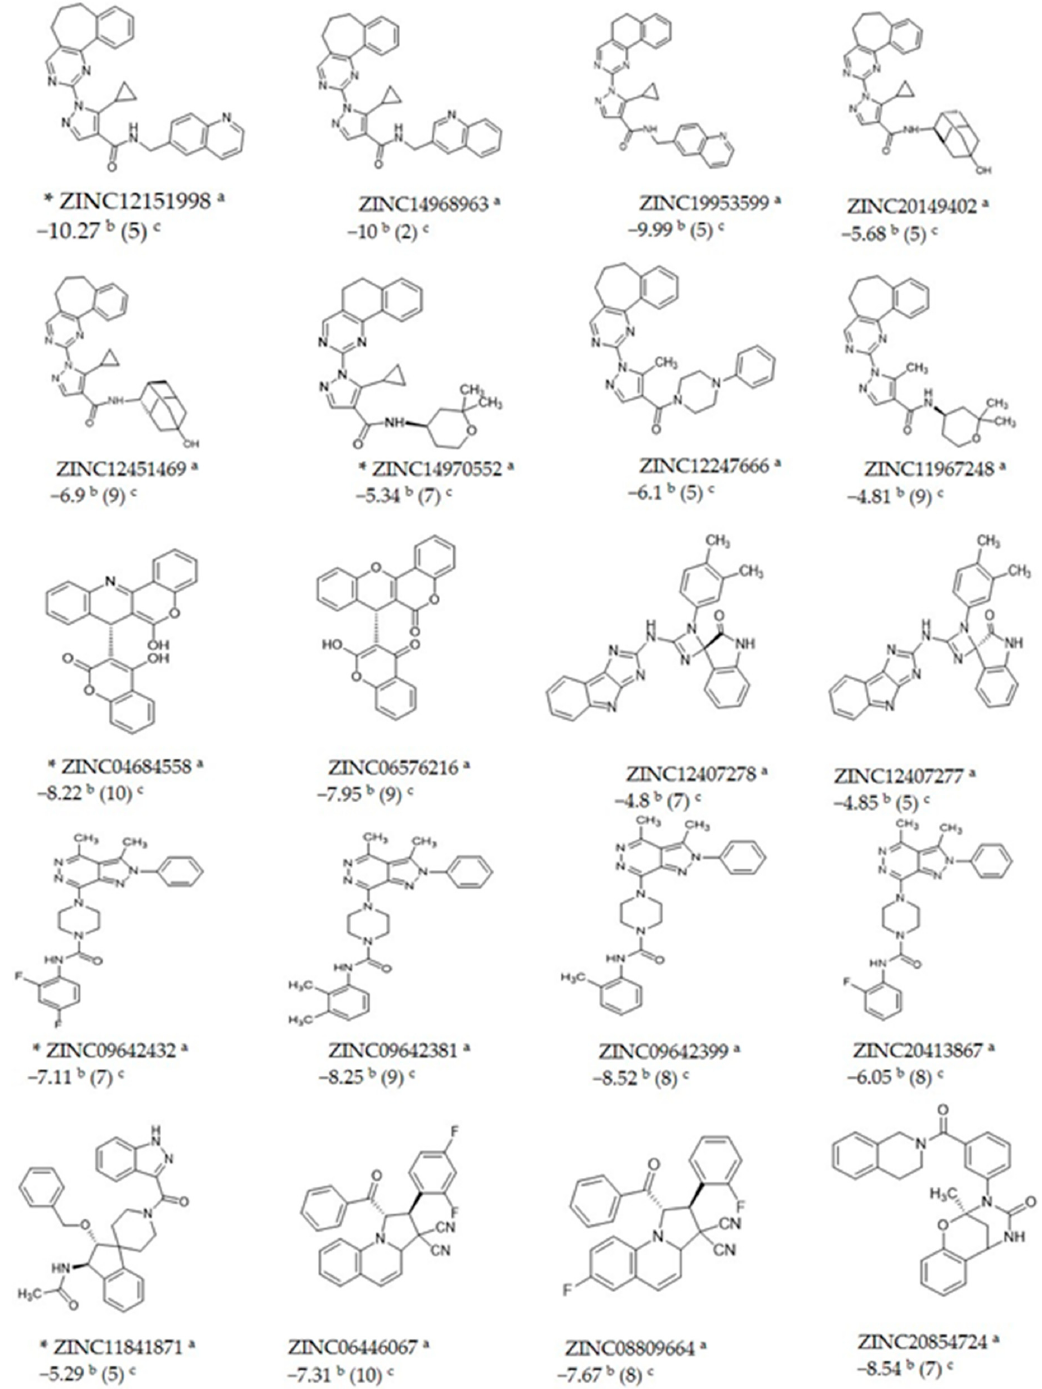
Figure 3. Docking scores (kcal / mol) and cluster sizes of compounds obtained with the AutoDock 4.2 program. * Compounds selected to test their inhibitory activity against rLmTR. a ZINC code, b ∆ G bind (kcal / mol), c Cluster